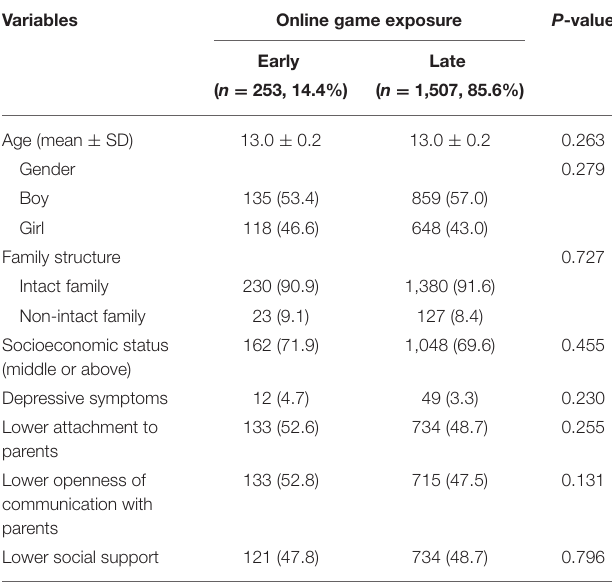
TABLE 1 | Baseline characteristics according to early or later exposure to online games among 1,760 adolescents who have ever played online